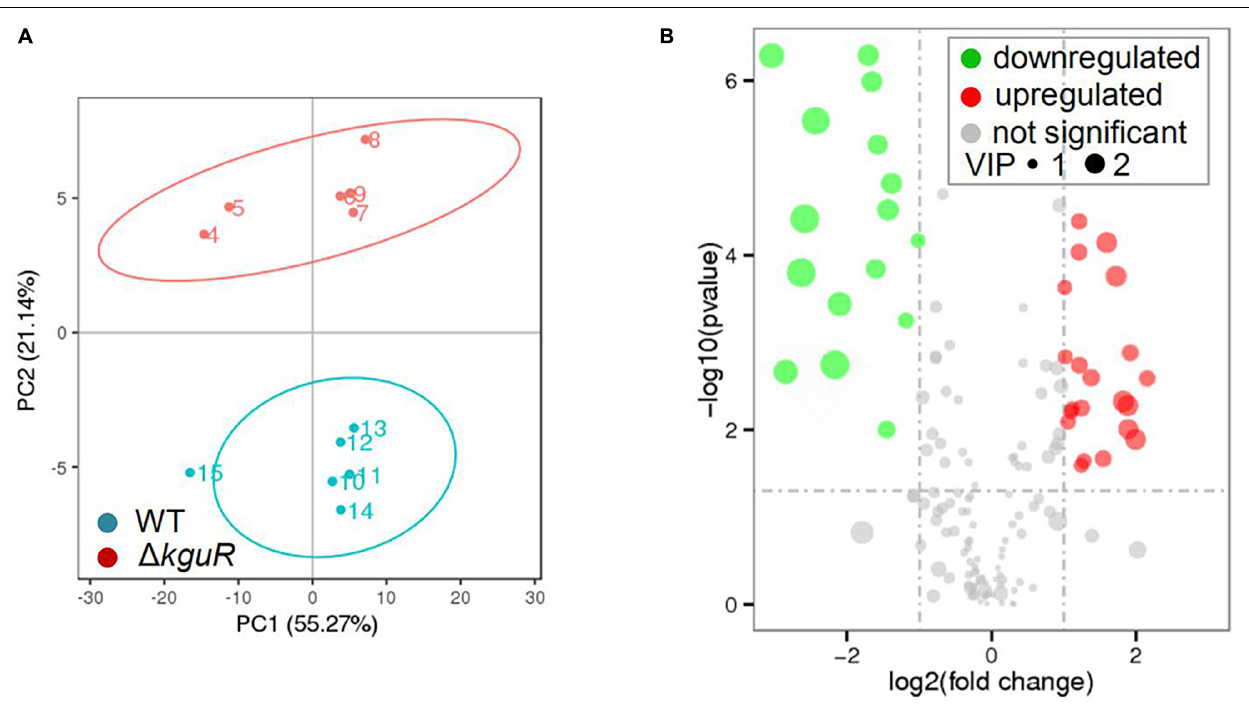
Frontiers in Microbiology |